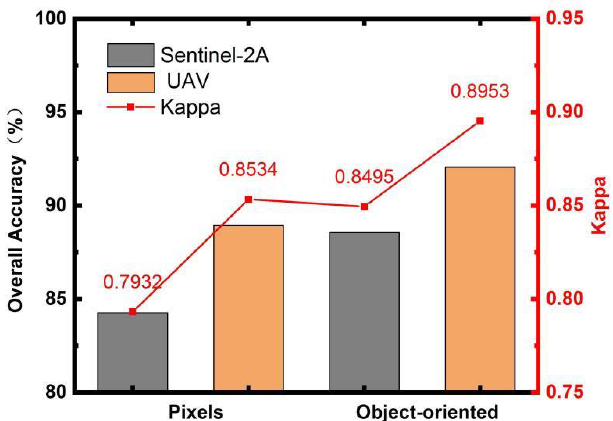
Figure 13. Precision evaluation of crop classification results with different image types and different classification methods.